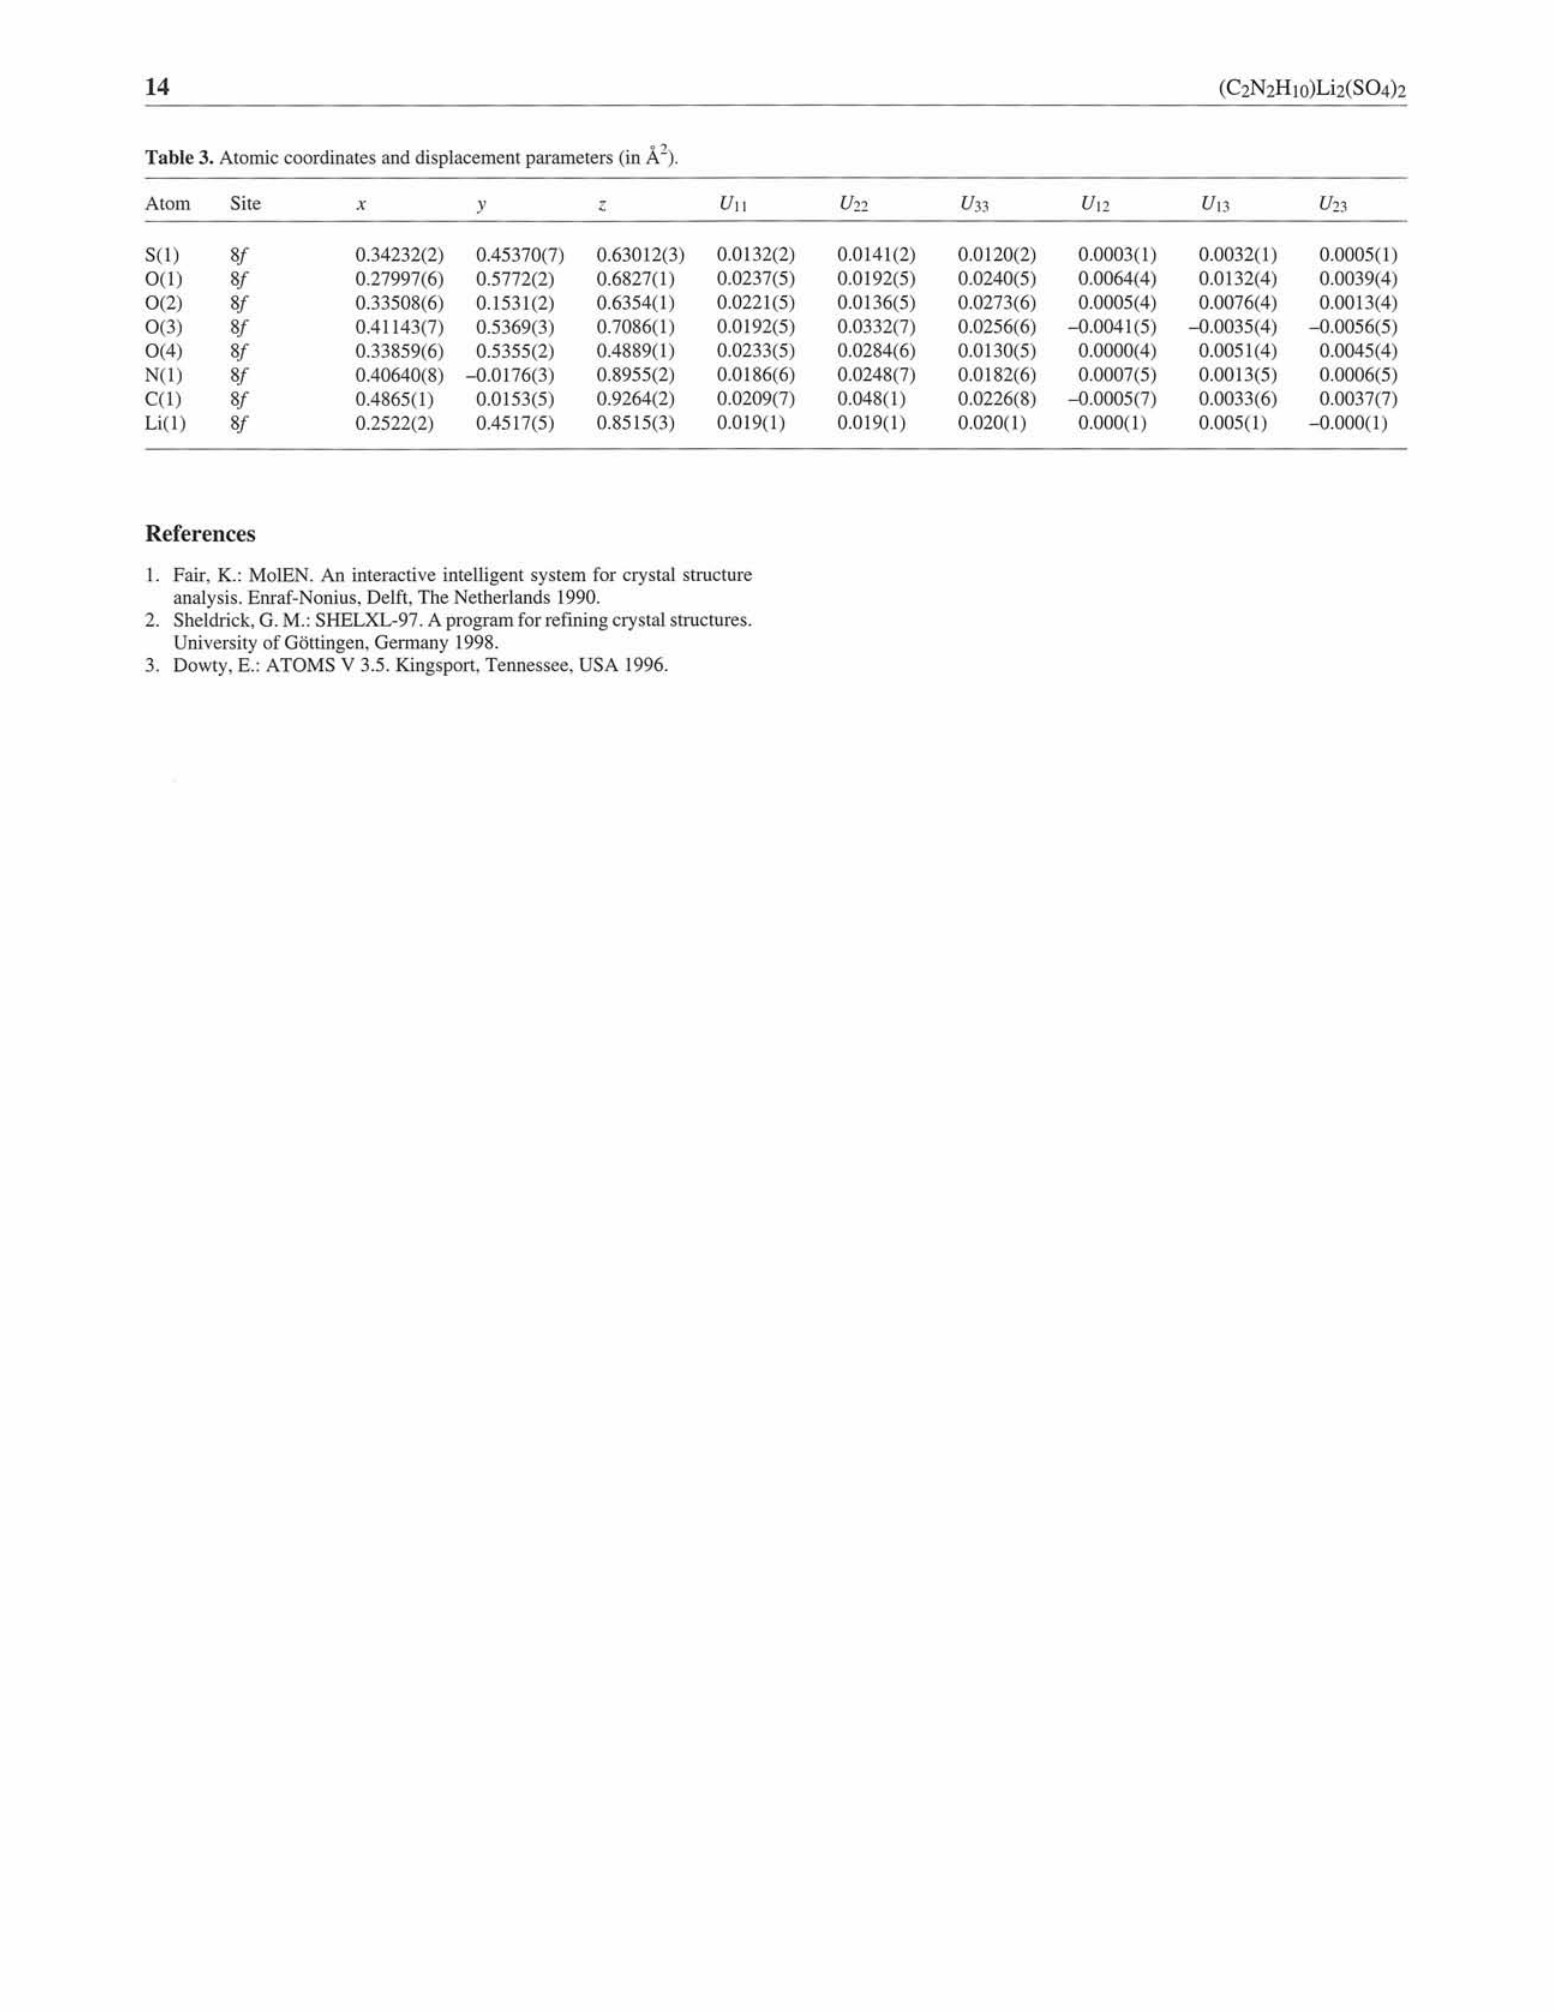
Table 3. Atomic coordinates and displacement parameters (in Â 2